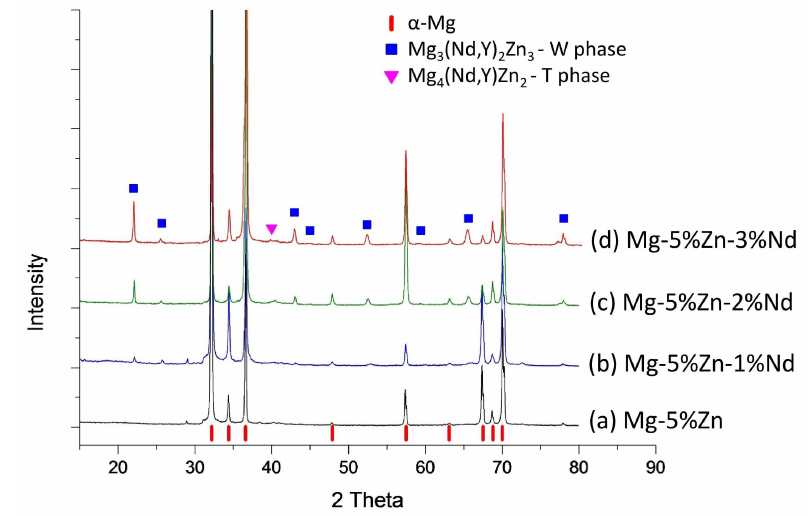
Figure 3. Microstructure magnification of Mg-5%Zn-3%Nd alloy ( a ) Close up view of precipitant at grain boundary (SE images) ( b ) Corresponding EDS analysis of the shown precipitant.